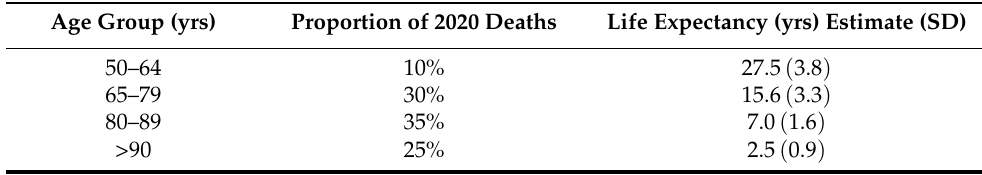
Table 1. Proportion of deaths in 2020 in Sweden by age group and life expectancy by age group. Data source: Statistics Sweden